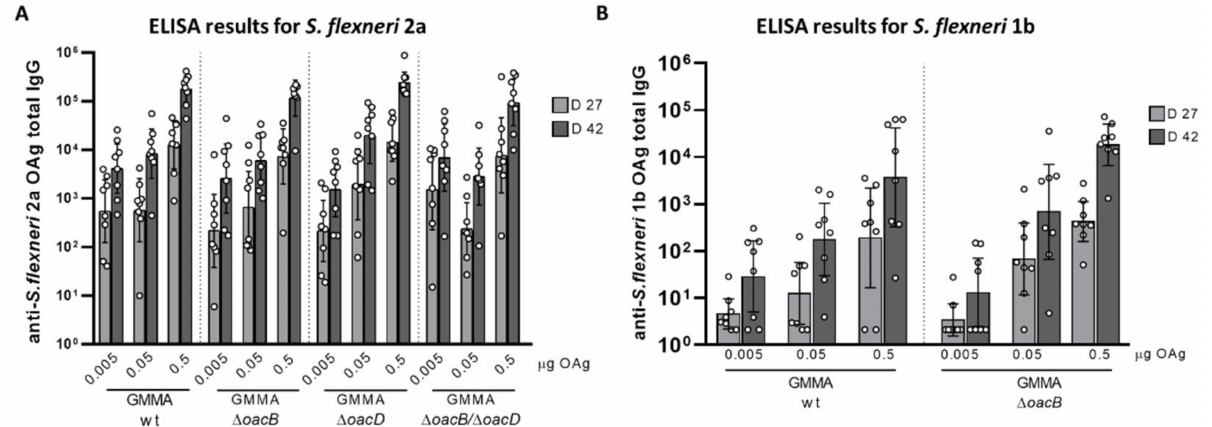
Figure 2. ELISA results of total anti-OAg specific IgG of S. flexneri 2a GMMA ( A ) and S. flexneri 1b GMMA ( B ) differing for OAg O-acetylation. Eight wild type (CD1) mice per group were intraperitoneally immunized on days 0 and 28, with 0.005, 0.05, and 0.5 µ g OAg dose. Summary graphs of anti-OAg specific IgG report individual antibody levels (dots) and geometric mean with 95% confidence interval